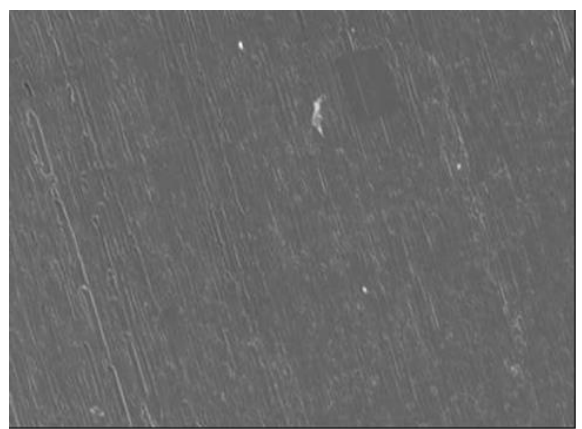
Fig. 2. Image of nozzle needle surface structure in its bottom, cylindrical (guiding) part. Characteristic places of attrition passing perpendicular to the needle axis draw attention in the image. No traces of surface oxidation. The surface of greater smoothness (worn) than in the central part of the